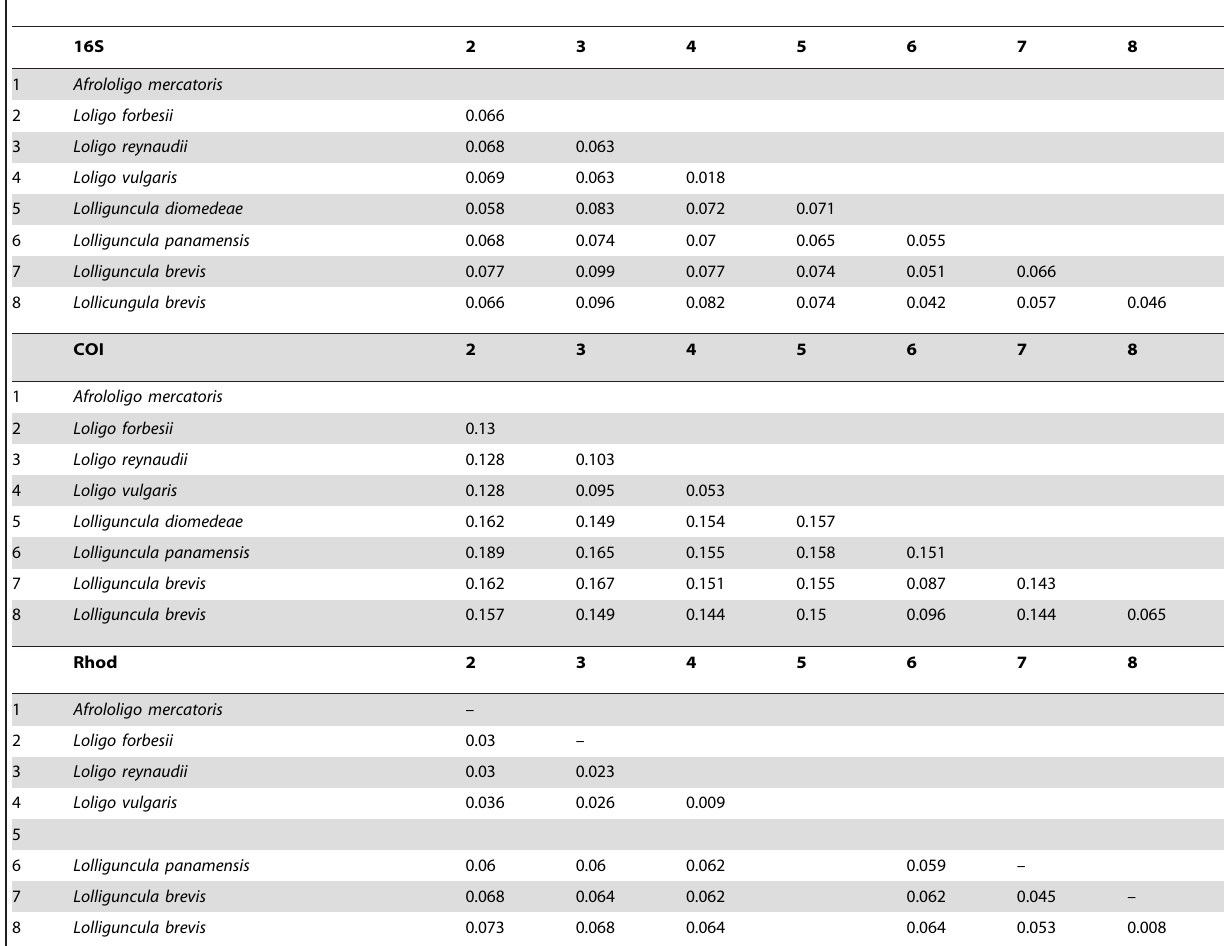
Table 2. Genetic divergences (P) estimated for two mitochondrial and one nuclear genes in the present